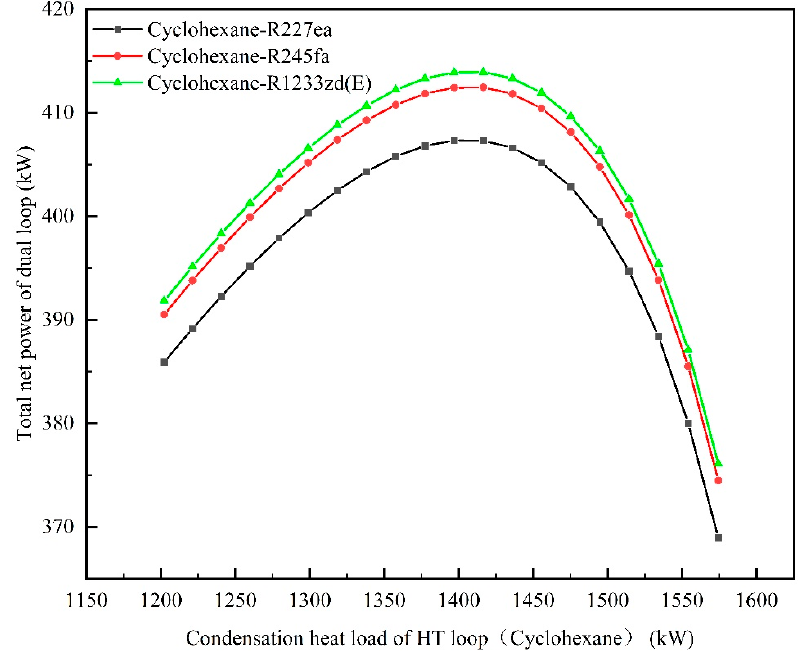
Figure 13. Total net power of the dual-loop system with cyclohexane as the HT loop working fluid.